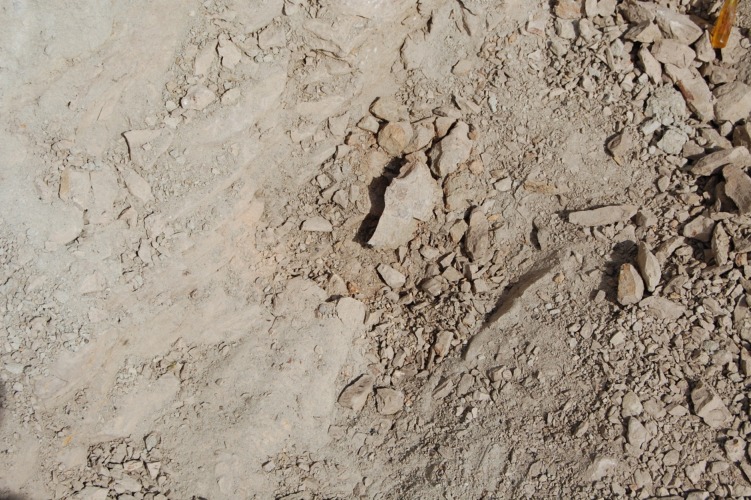
Centrosaurus tibia after matrix-surrounded sample and uncovered distal end were collected.